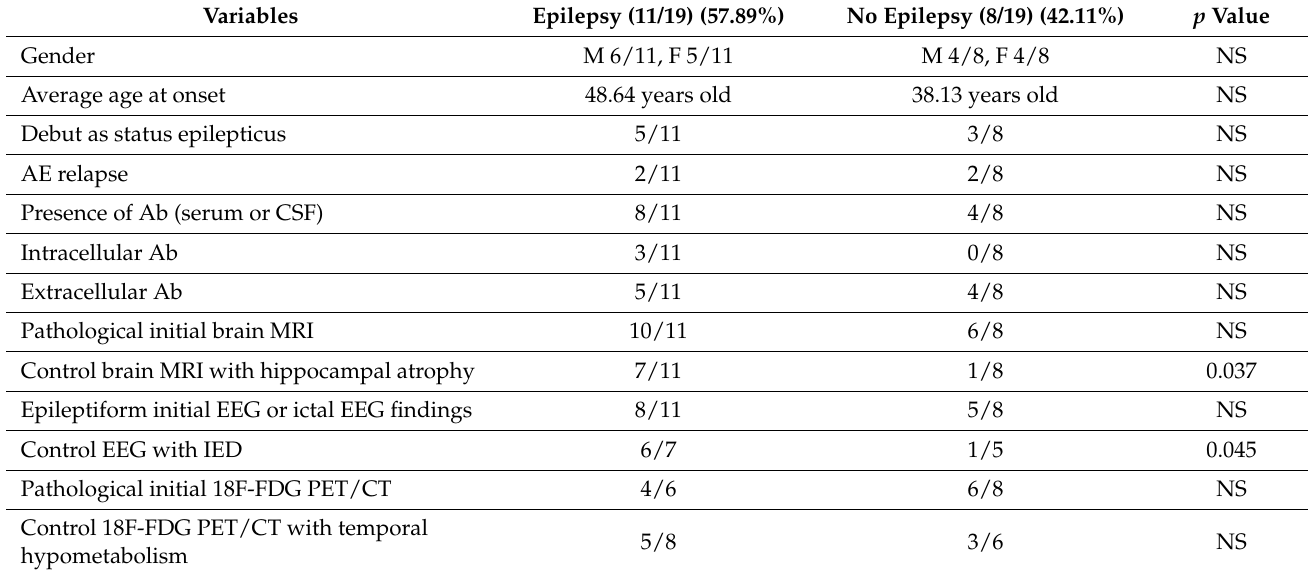
Table 2. Comparison of clinical and paraclinical variables of patients who developed epilepsy and those who did not.